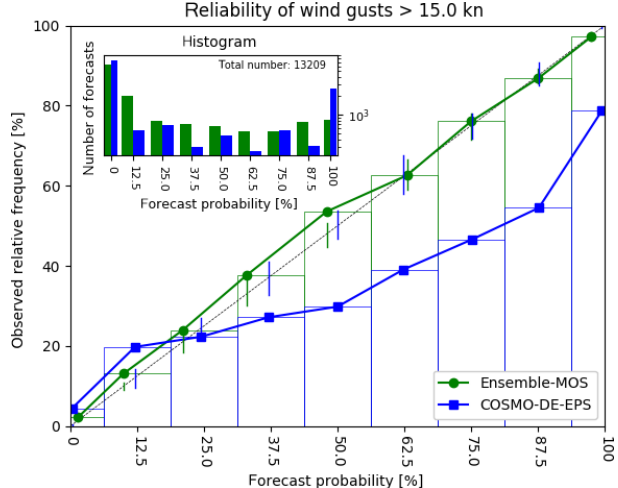
Figure 10. Reliability diagram for probabilities of wind gusts ex- ceeding 7.7ms − 1 (15.0kn). Probabilistic forecasts of Ensemble- MOS with a lead time of 6h (green) and corresponding relative fre- quencies of COSMO-DE-EPS with a lead time of 8h (blue). Verifi- cation is done for 3 months of data (May–July 2016) and 18 stations in Germany at about N52 ◦ latitude, including Berlin for example. Vertical lines are 5%–95% consistency bars according to Bröcker and Smith (2006).